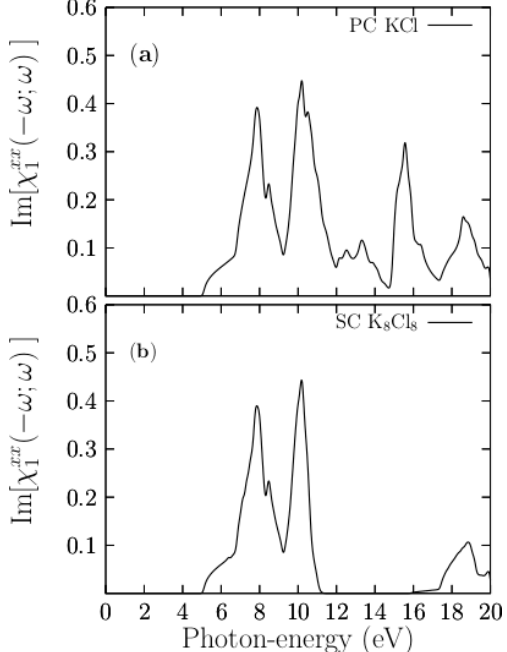
(cid:104) (cid:105) χ xx ( − ω ; ω ) part corresponding to pristine PC 1 ( ) xx χ ω ; ω   −   part corresponding to pristine 1